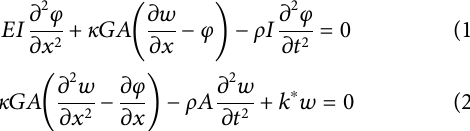
Frontiers in Materials |